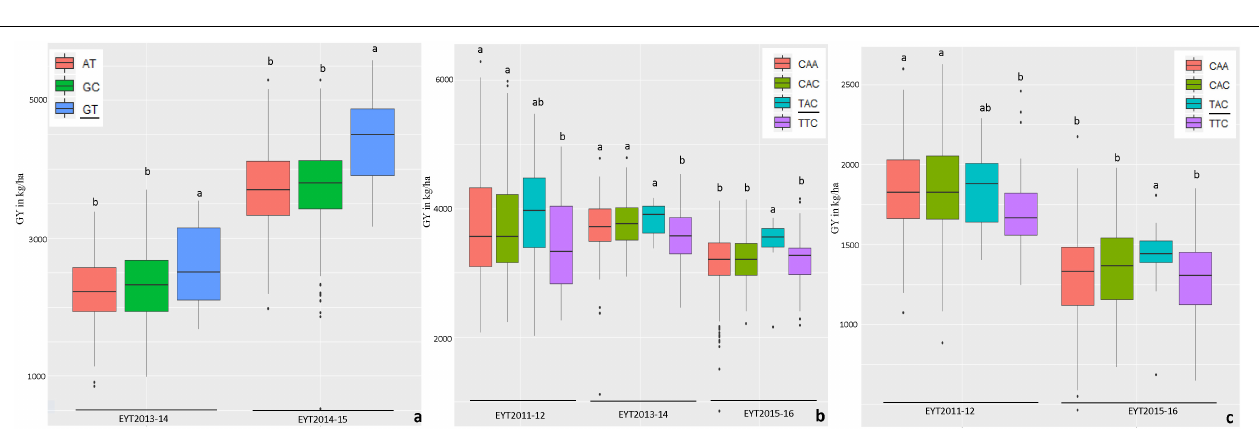
analyses for Pi , allelic effect ranged from 0.8 to 5.6% ( Supplementary Table S8